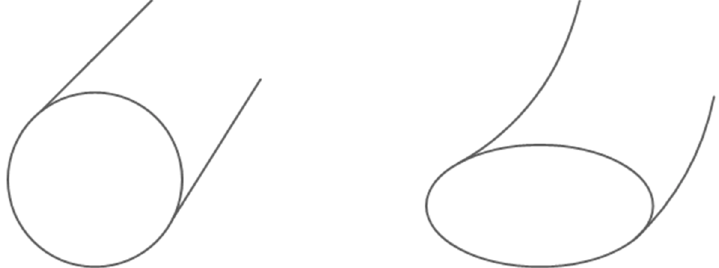
Figure 6. Cylinder made of an isotropic material. Left: in resting position with circular cross-section. Right: bent in the longitudinal direction, which turns the cross-section into an ellipse.